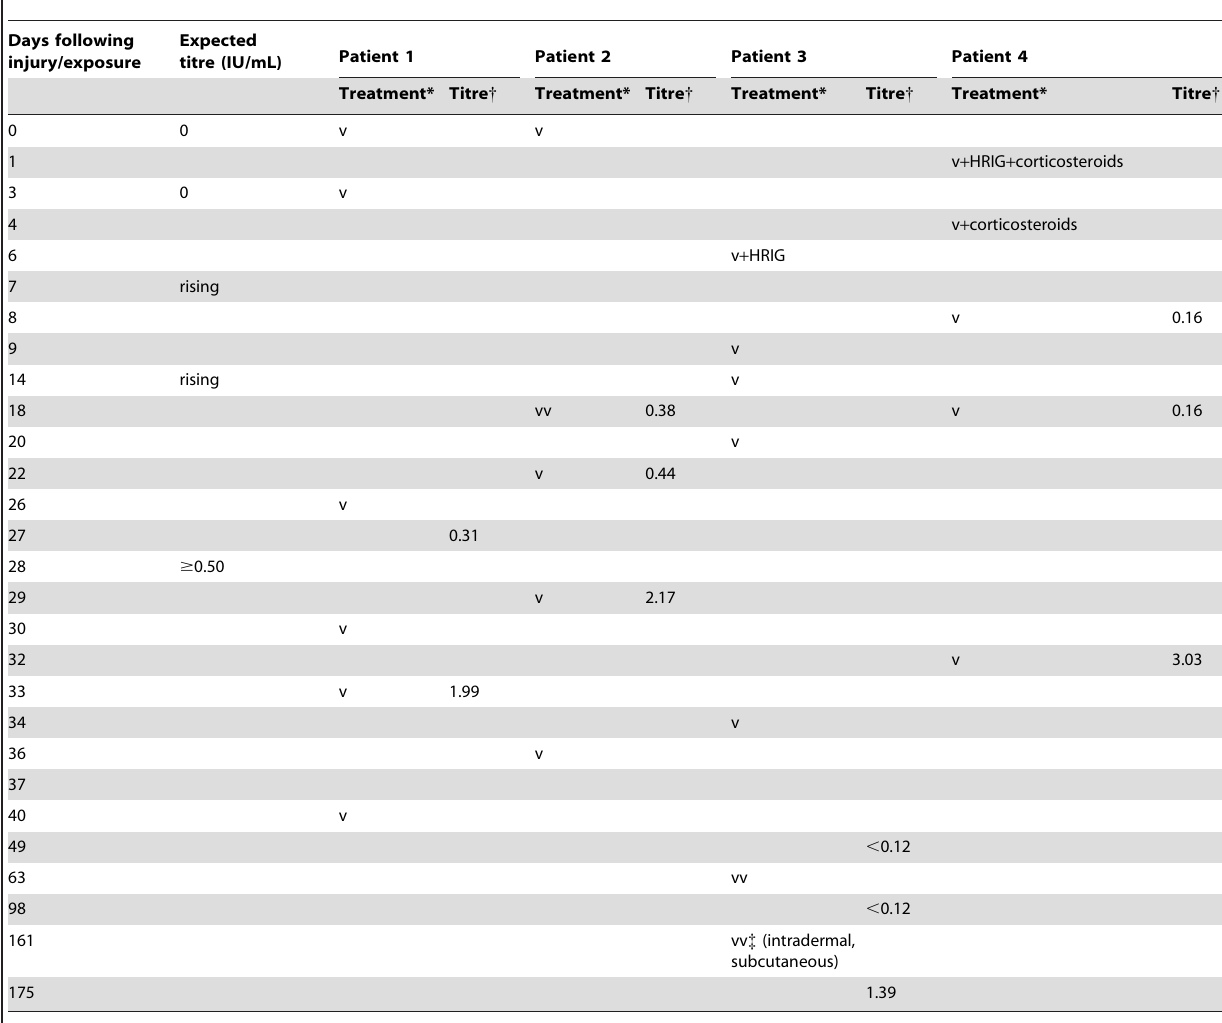
Table 1. Timing of treatment and serological testing following exposure to rabies virus or Australian Bat Lyssavirus.